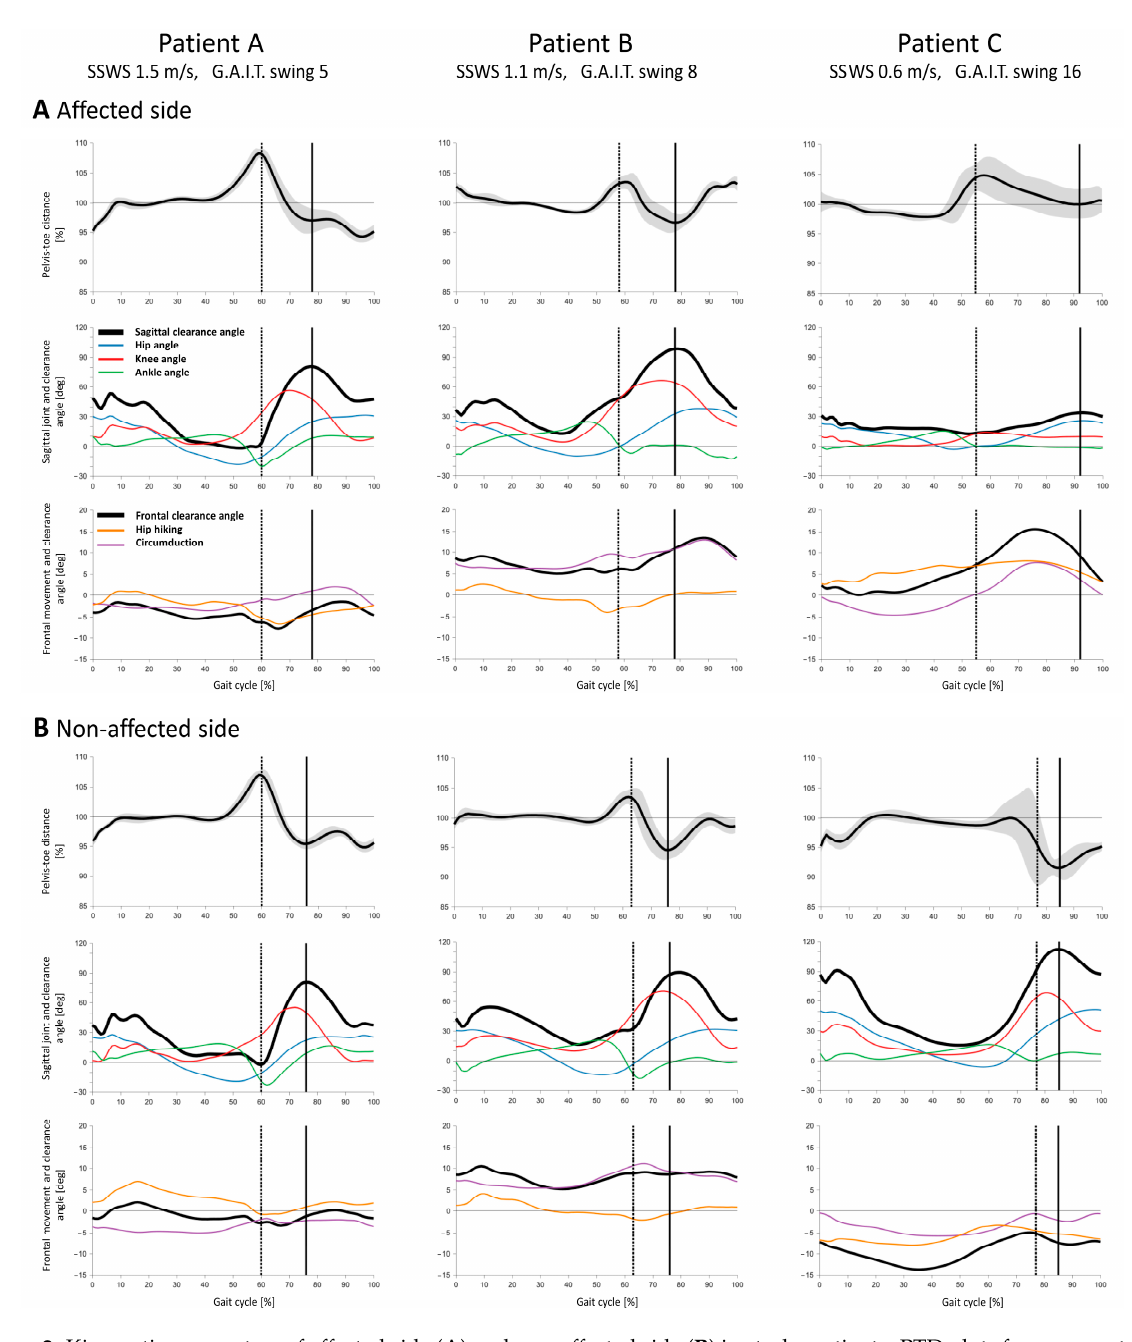
Figure 2. Kinematic parameters of affected side ( A ) and non-affected side ( B ) in stroke patients. PTD plots for representative cases of 3 stroke patients ( top ), plots for the sagittal plane joint angle and the SC angle ( middle ), and plots for the frontal compensatory motion angle and the FC angle ( bottom ) are shown. Abbreviations: SSWS, self-selected walking speed; GAIT; Gait Assessment and Intervention